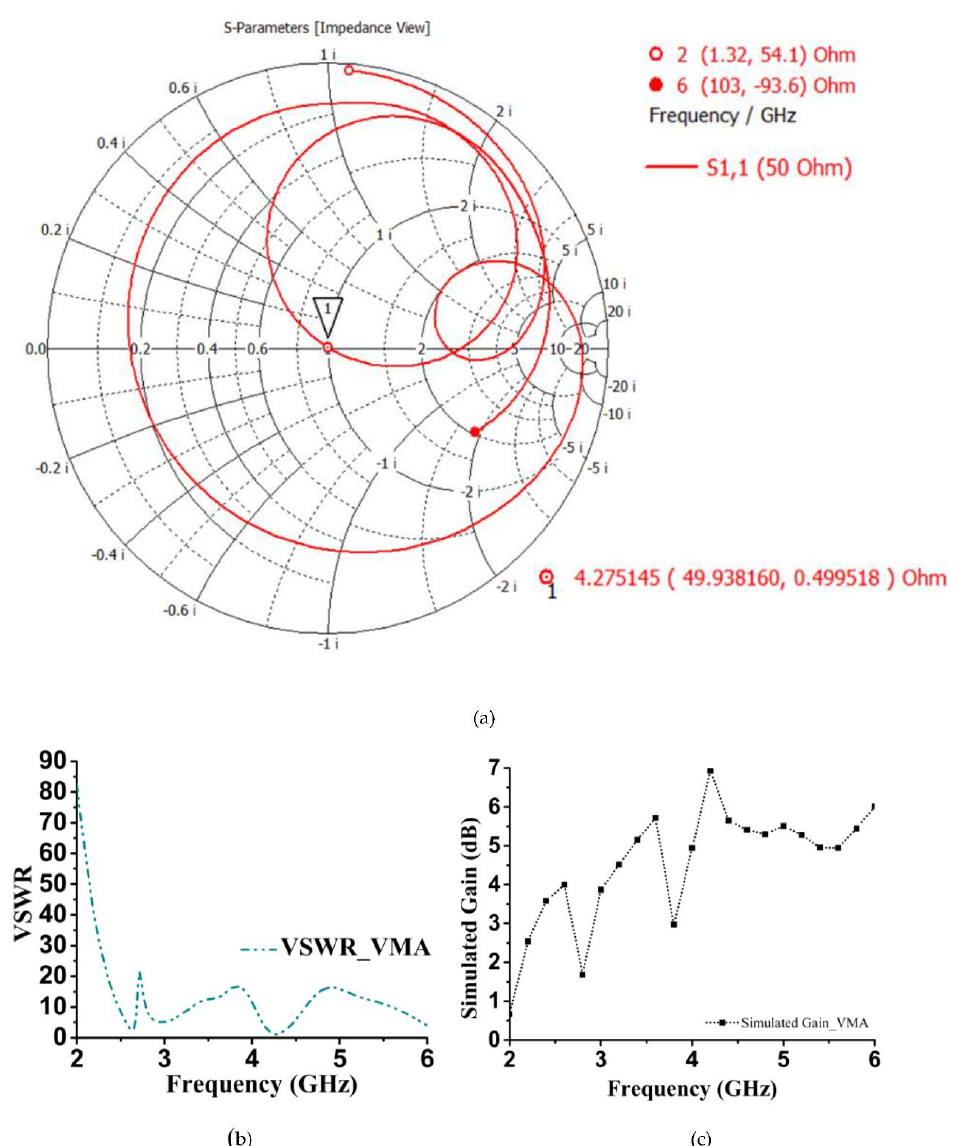
Figure 10. Proposed retro VMA performance; ( a ) Smith chart for impedance characteristics; ( b ) VSWR; and ( c ) simulated gain (dB).